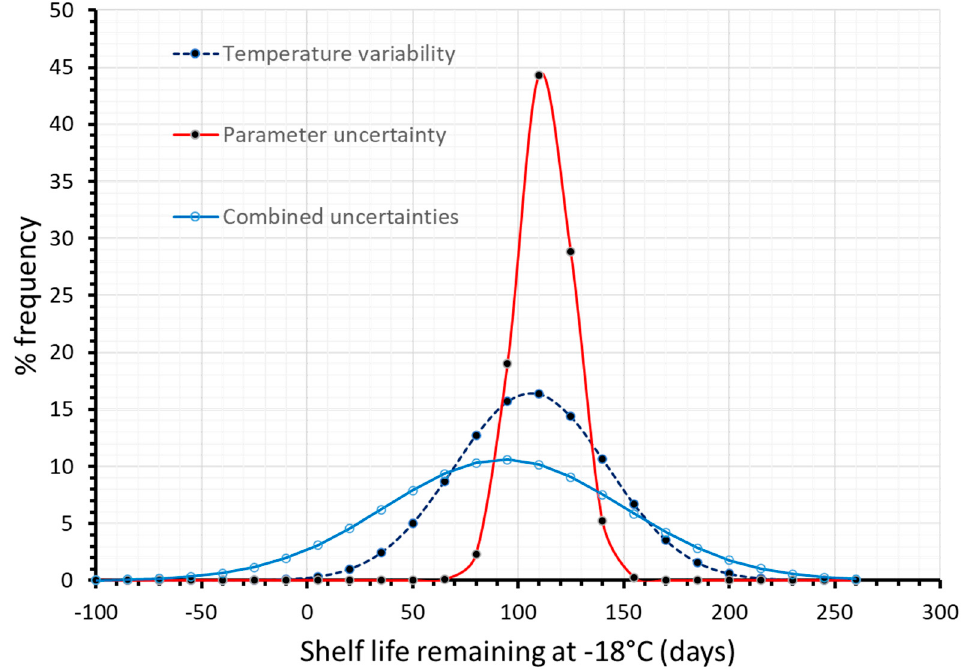
Figure 6. Remaining shelf life of frozen green peas, after 130 days in the cold chain, when only temperature variability (dashed blue line), only parameter uncertainty (red line) or both temperature variability and parameter uncertainty (solid light blue line) were incorporated within model’s prediction algorithm.